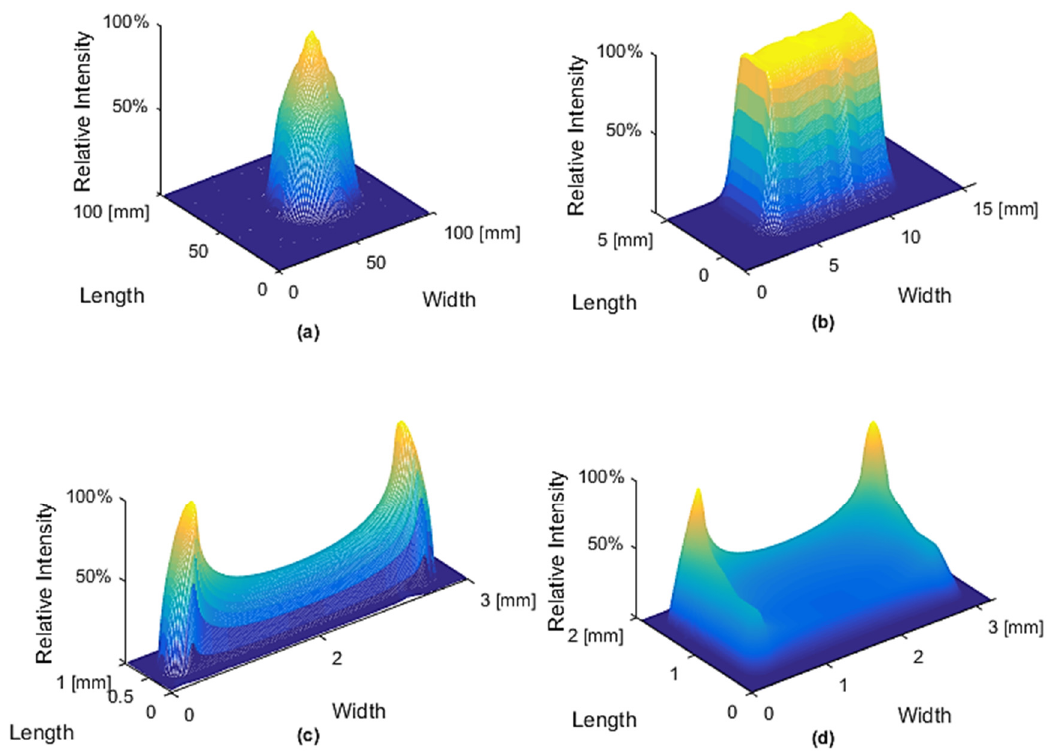
Figure 1. For laser hardening, four intensity profiles are commonly used. The defocused round top-hat profile ( a ); the rectangular top-hat profile ( b ); the intensity profile generated by a harmonic oscillation of a scanning mirror ( c ) as well as the optimized intensity profile which was calculated by Burger [10].